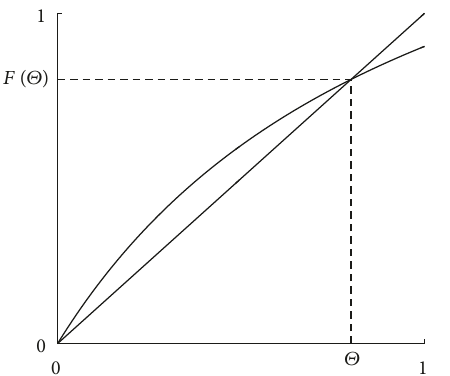
Figure 1: The equilibrium relationship graph of credit risk contagion system.